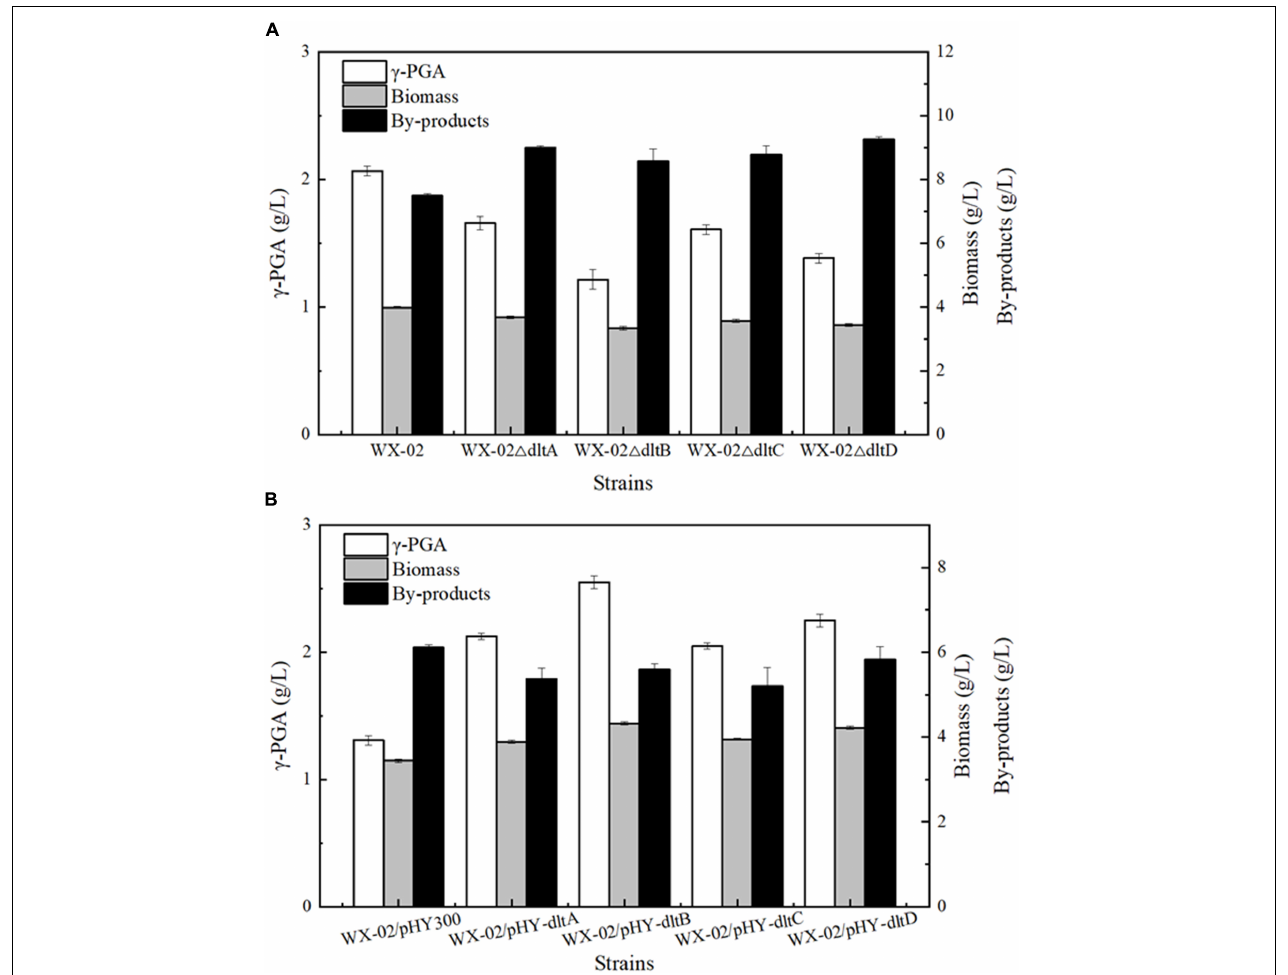
FIGURE 1 | Effects of deletion and overexpression of dlt operon on γ -PGA and by-products production. (A) The γ -PGA yields, biomass formation and by-products yields of WX-02, WX-02 (cid:49) dltA , WX-02 (cid:49) dltB , WX-02 (cid:49) dltC , and WX-02 (cid:49) dltD . (B) The γ -PGA yields, biomass formation and by-products yields of WX-02/pHY300, WX-02/pHY- dltA , WX-02/pHY- dltB , WX-02/pHY- dltC , and WX-02/pHY- dltD .